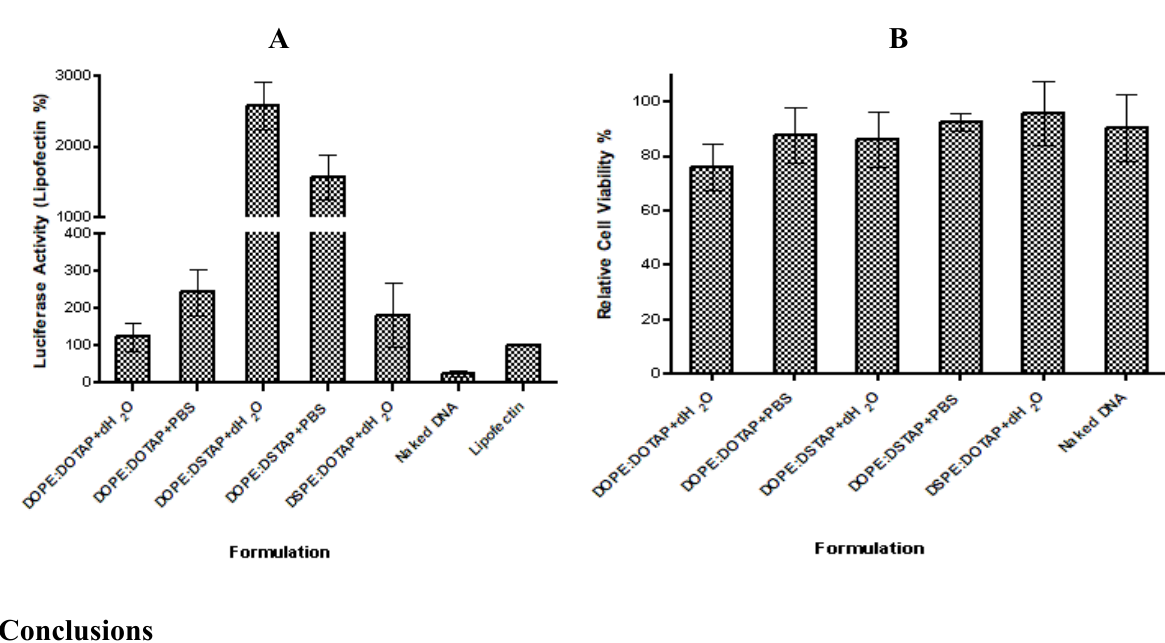
Figure 5. ( A ) Comparison of transfection efficiency of five cationic liposomes formulated with distilled water or PBS. Results denote mean ± SD, n = 3. ( B ) Relative cell viability of five cationic liposomes formulated with distilled water or PBS. Results denote mean ± SD, n = 3. A